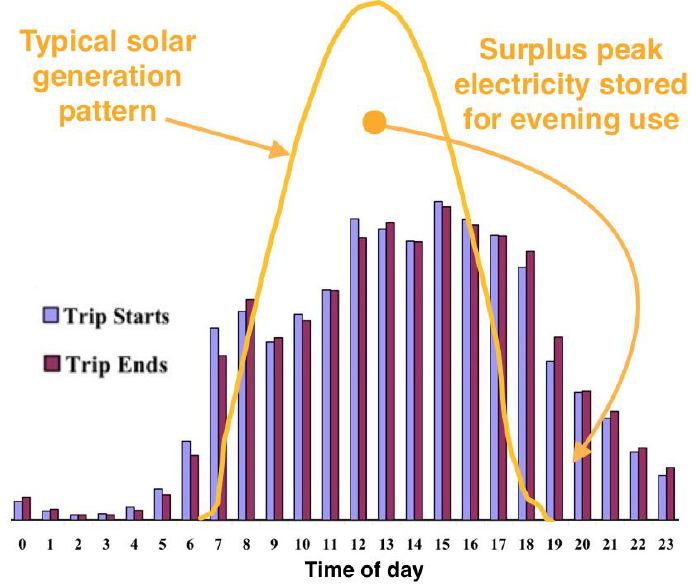
Figure 8. The sun’s daily supply curve nearly matches a typical daily traffic demand curve [23]. Vehicle-to-Grid (V2G) schemes are promoted for grid stabilization, but such schemes assume